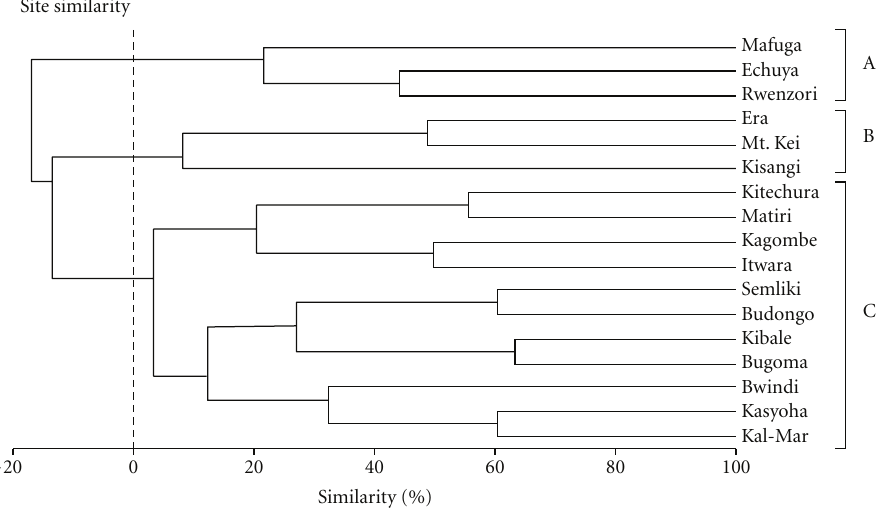
Figure 4: Clustering of the study forests based on the presence or absence of butterfly